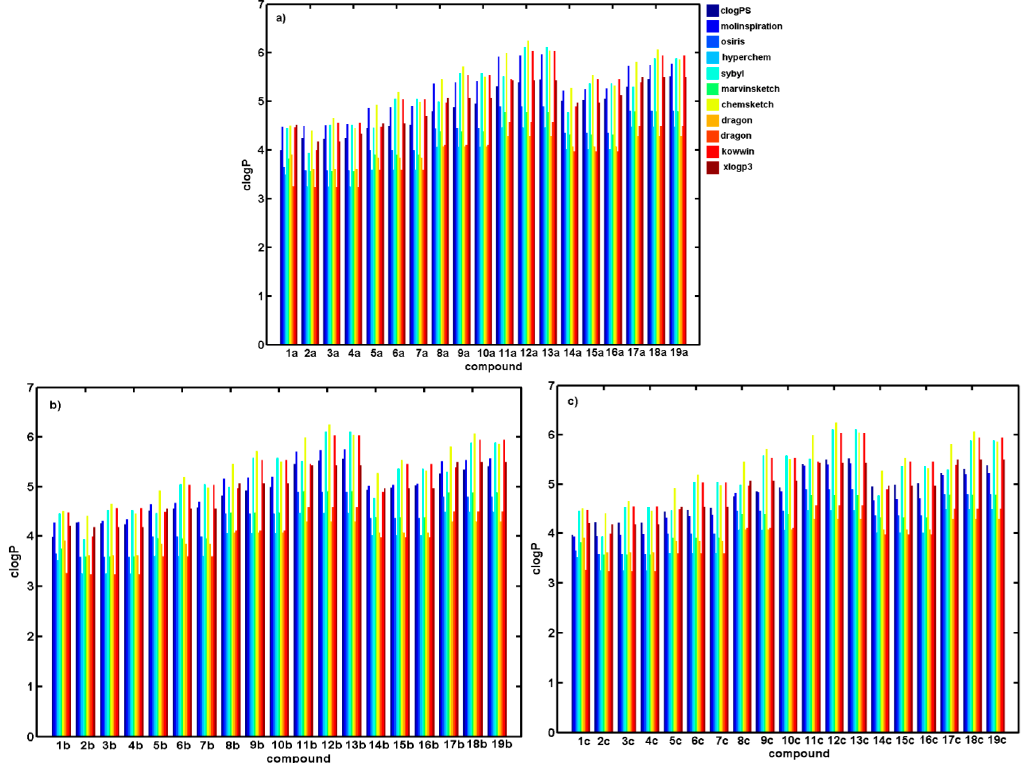
Figure 1. Theoretical partition coefficient calculated by alternative methods for ( a ) N -alkoxyphenyl- 3-hydroxynaphthalene-2-carboxanilides 1a – 19a (series A), ( b ) N -alkoxyphenyl-1-hydroxynaphthalene- 2-carboxanilides 1b – 19b (series B), and ( c ) N -alkoxyphenyl-2-hydroxynaphthalene-1-carboxanilides 1c – 19c (series C).